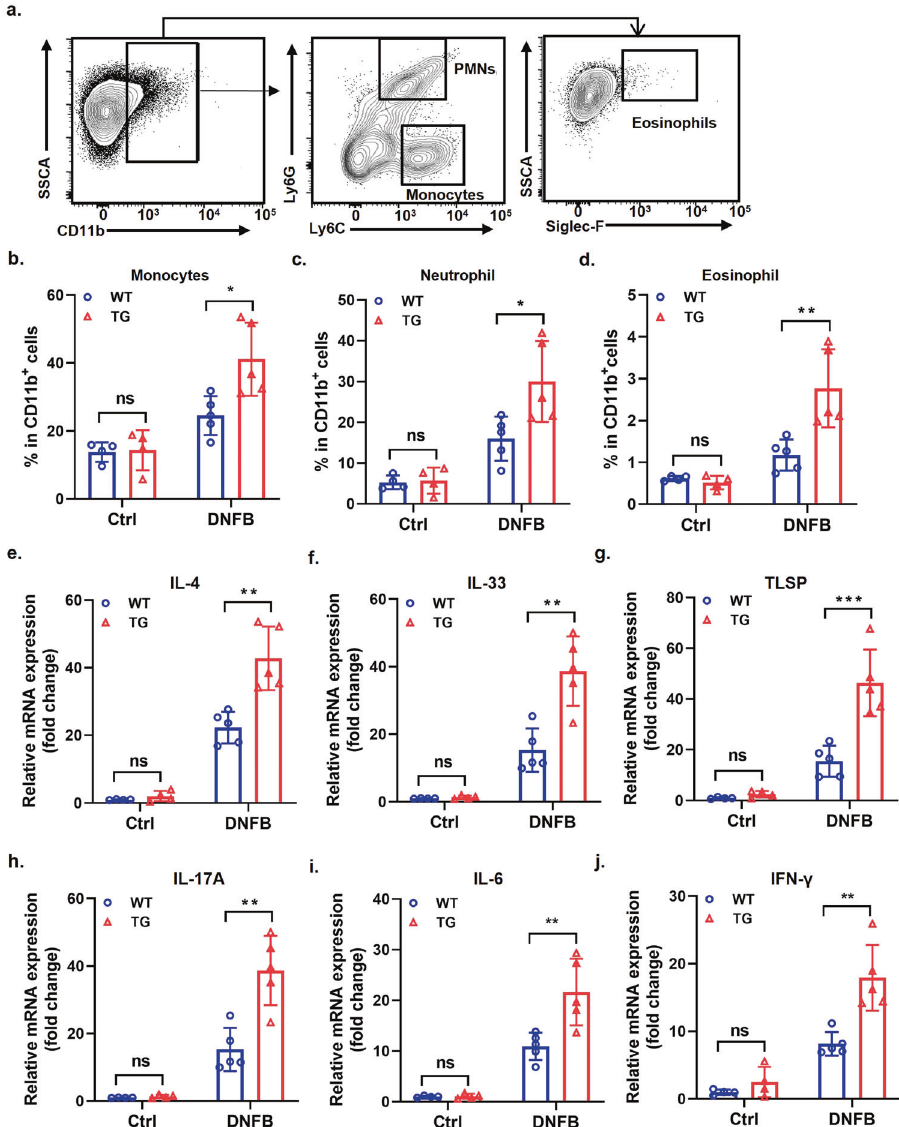
Fig. 5 WFDC12-overexpressing enhanced immune responses in mice epidermis. a Flow cytometric analysis of bone marrow cells (BMCs) in mice epidermis. b – d The ratio of monocytes ( b ). neutrophil ( c ) and eosinophil ( d ) in CD11b + cells in mice epidermis ( n = 4 or 5). e – j RT-qPCR analysis of IL-4 ( e ), IL-33 ( f ), TLSP ( g ), IL-17A ( h ), IL-6 ( i ). and IFN- γ ( j ) ( n = 4 or 5). Data were expressed as mean ± SD. Asterisks indicate statistical signi fi cance based on unpaired or paired T -test; * p < 0.05, ** p < 0.01, *** p < 0.001, ‘ ns ’ indicates no statistical